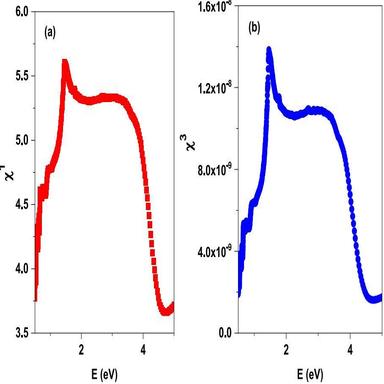
(a) Photon energy dependence of tanδ, (b) Photon energy dependence ofχ1 and (c) Photon energy dependence ofχ3 of PVA structure.